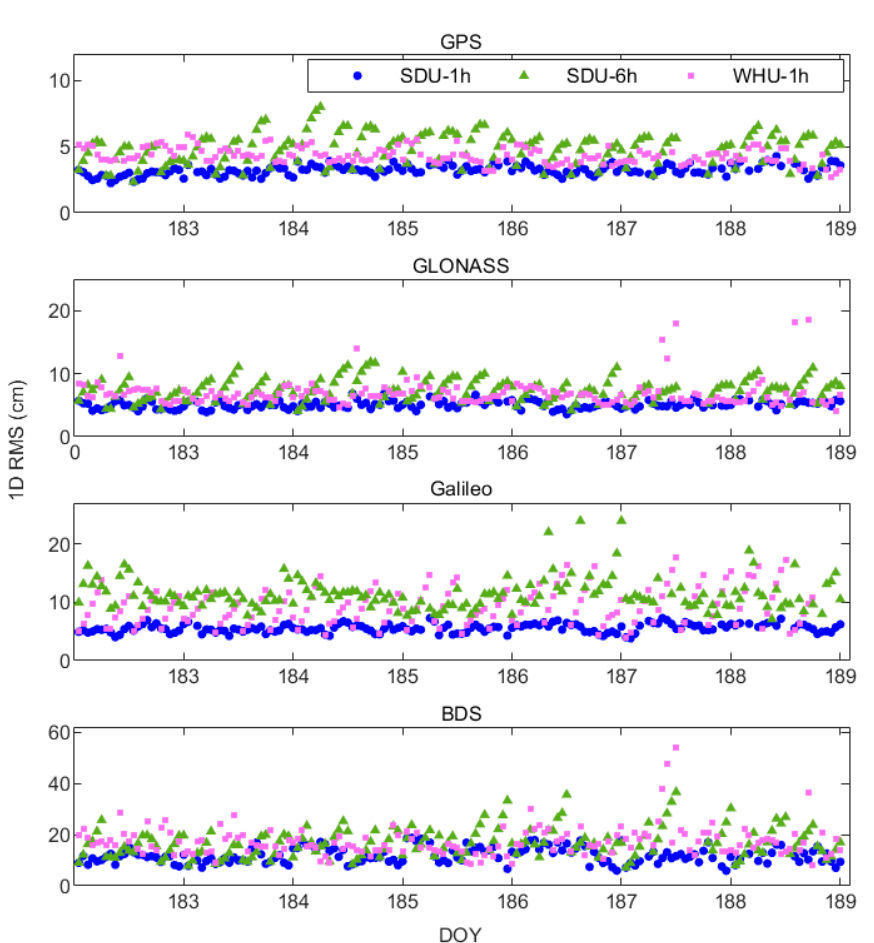
Figure 11. RMS of GPS, GLONASS, Galileo and BDS (from top to bottom) orbit of SDU-1h, SDU-6h and WHU-1h compared with CODE precise orbit.